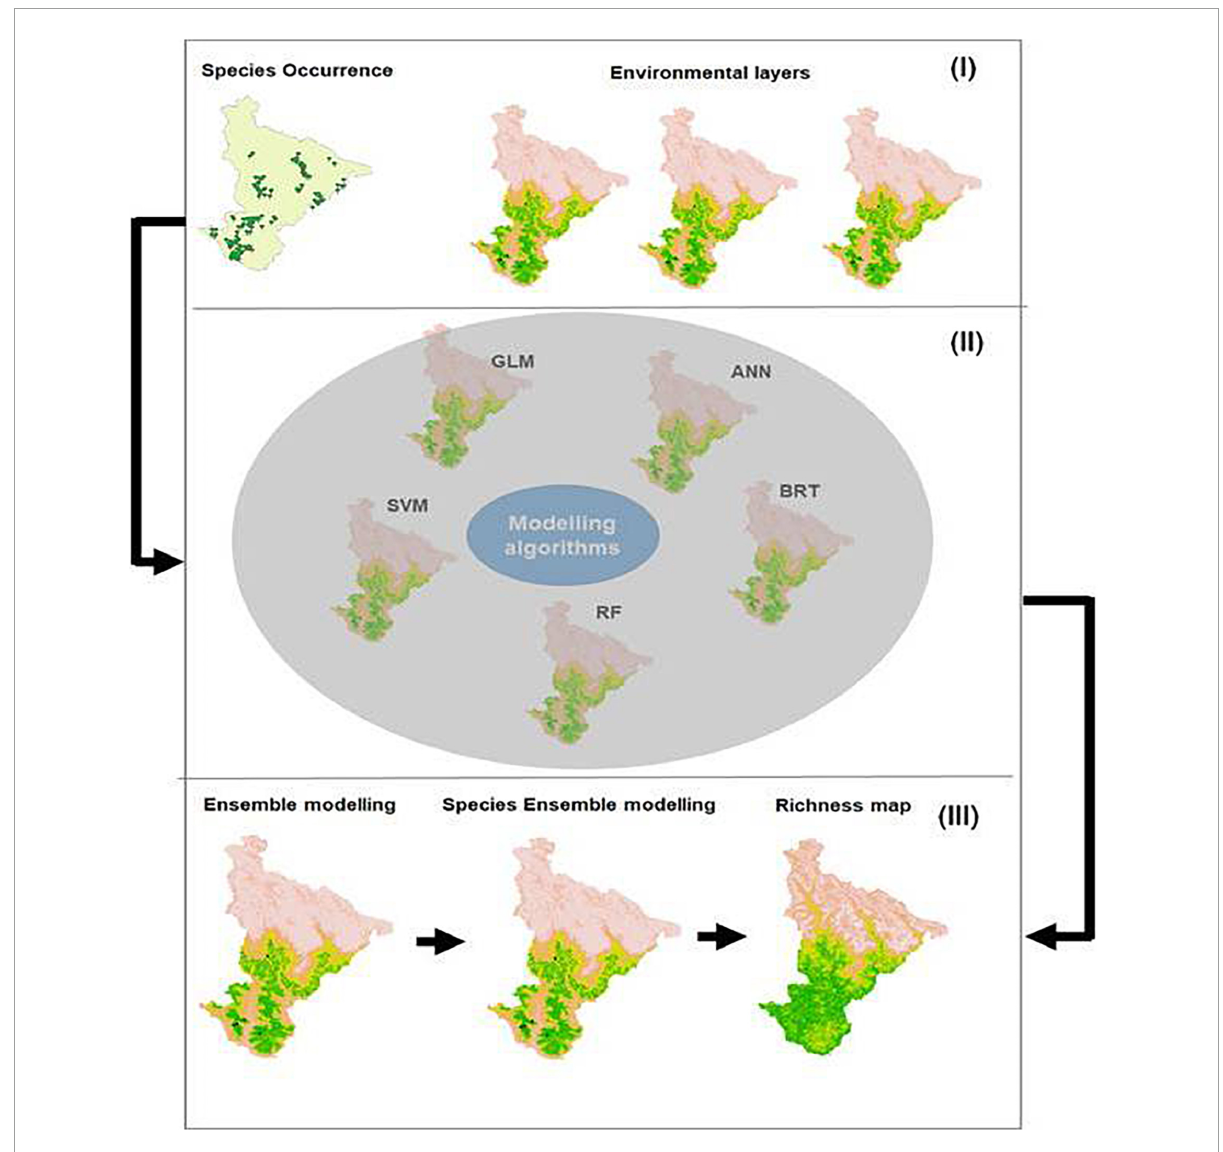
FIGURE2 Methodological flow diagram of SSDM approach. (I) Input species occurrences and environmental layers; (II) modeling algorithms for deriving binary maps; and (III) ensembling binary maps to produce community-level